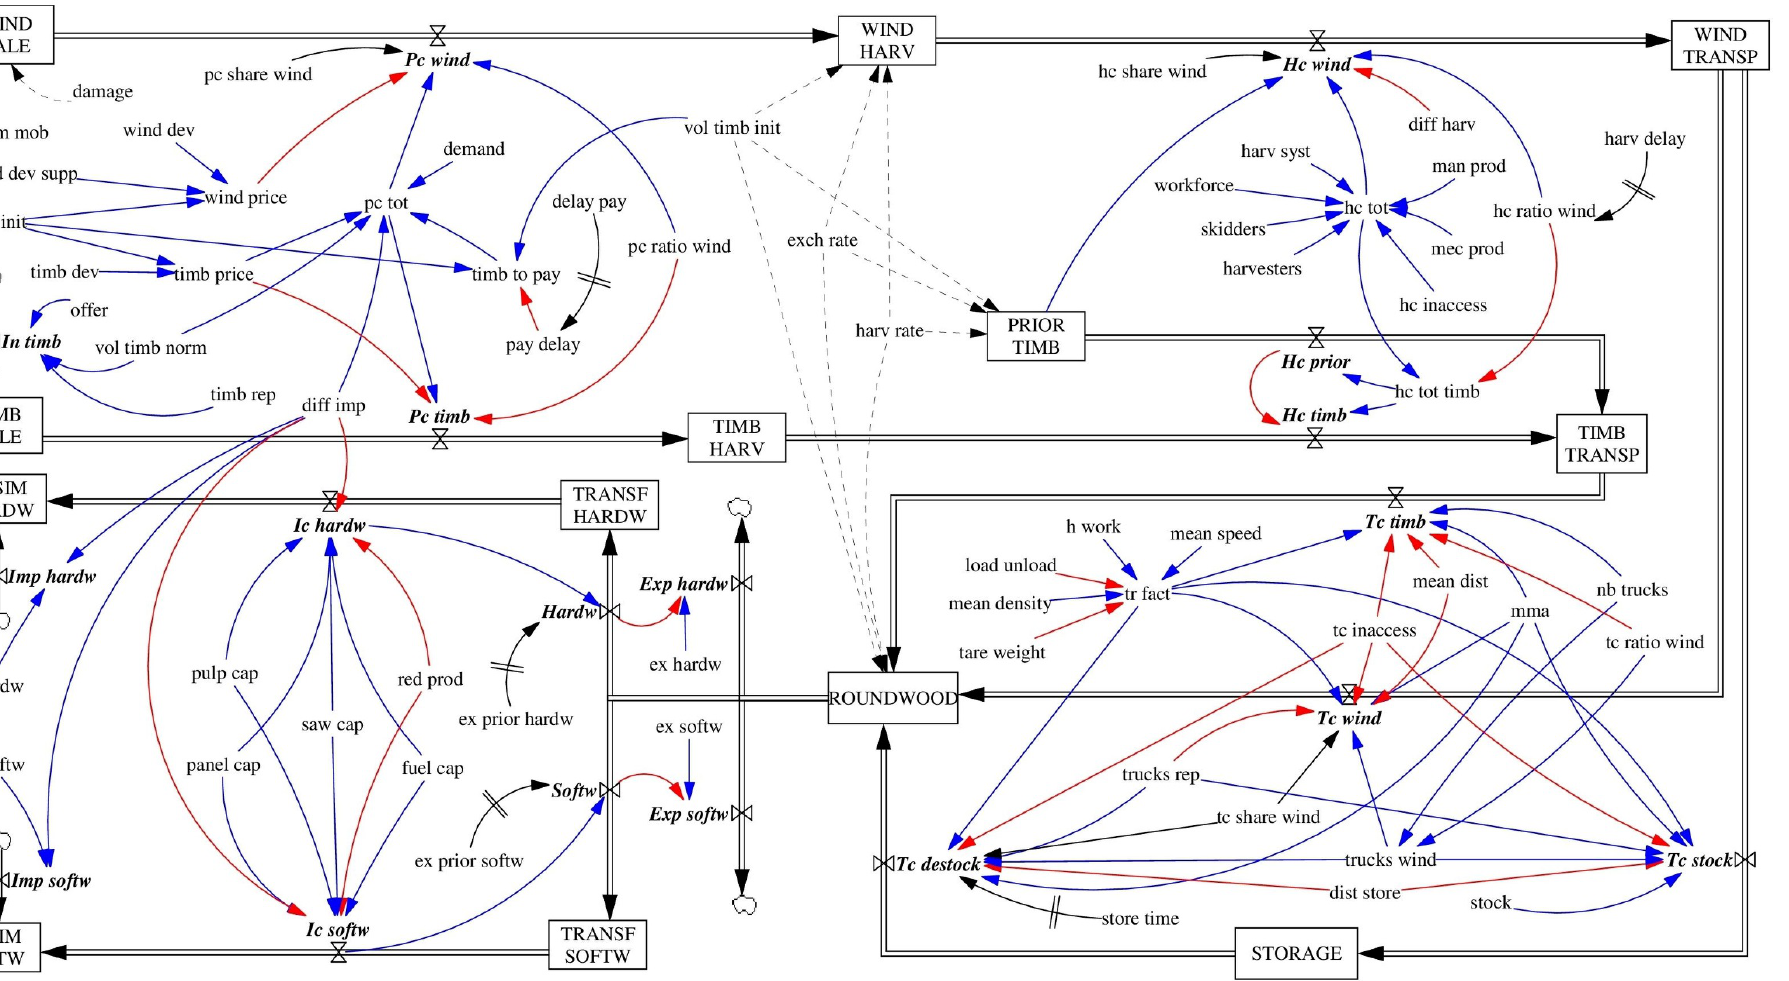
Figure 2. WALFORM model structure and parameters. Boxes represent stocks, double arrows with hourglasses flows (in italic and bold). Blue (red) arrows indicate a positive (negative) influence between converters. Dashed arrows indicate that the converter determines only the initial value of a stock. Black arrows with delay marks indicate that a time delay may be applied to the targeted